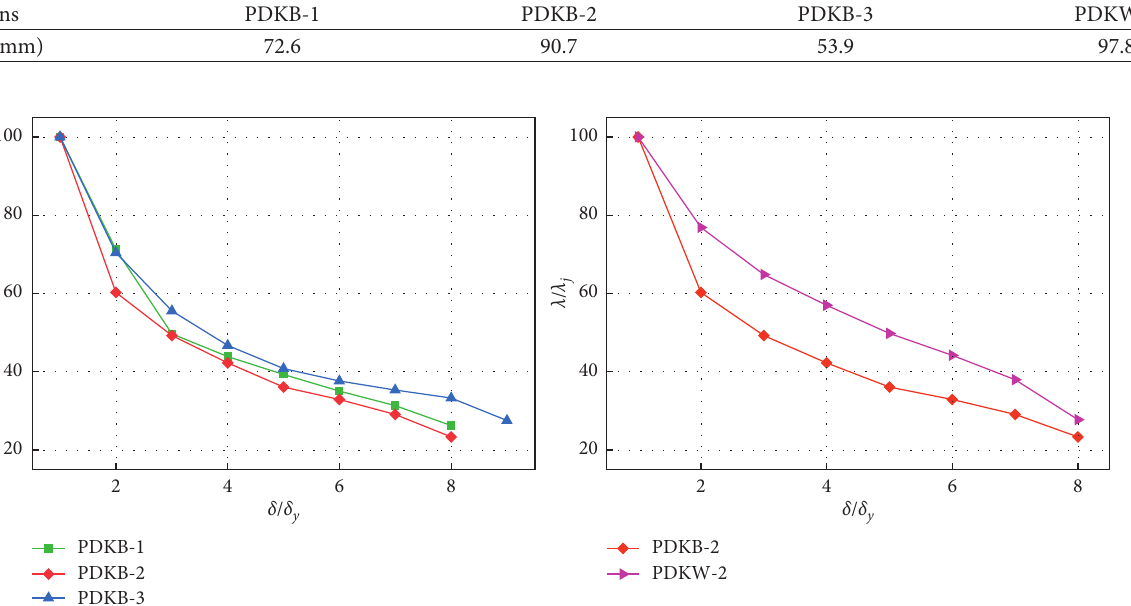
Figure 20: Rigidity degradation curve.